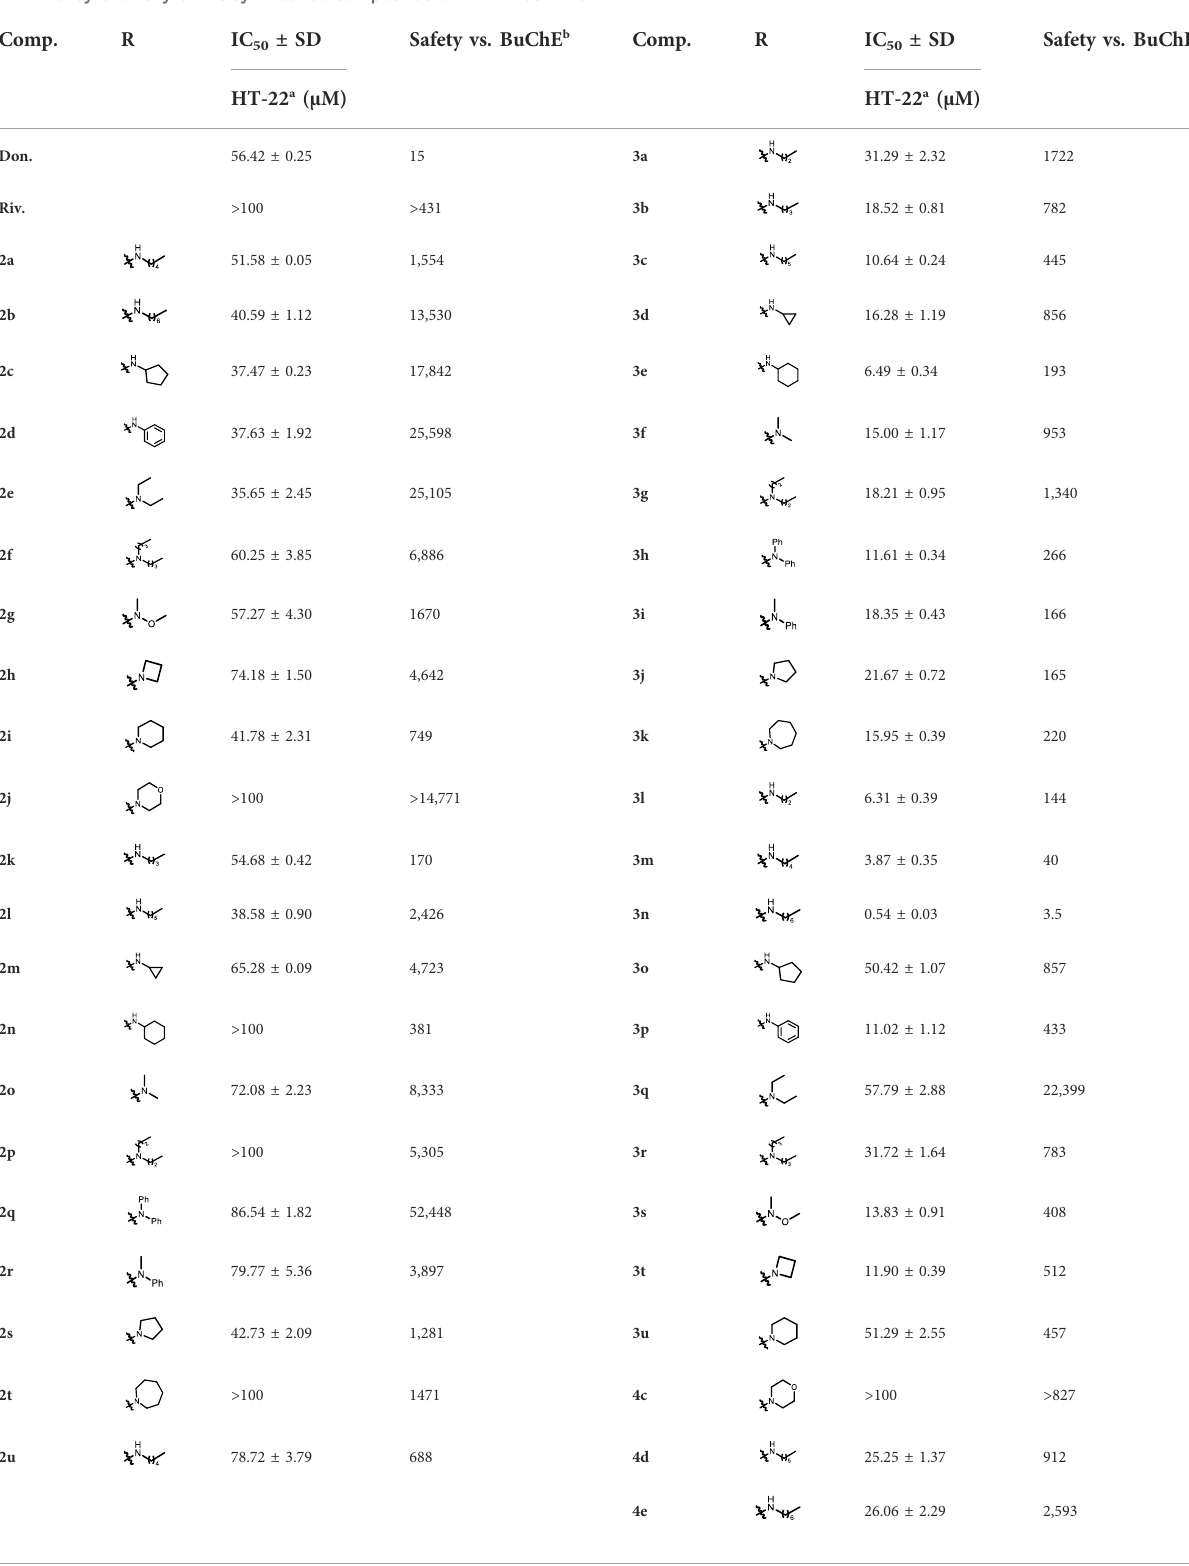
TABLE 3 Cytotoxicity of the synthesized compounds on HT-22 cell line. Comp. R